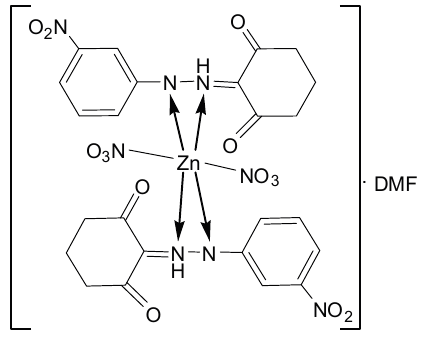
Figure 8. Structure of [Zn(L 2 ) 2 (NO 3 ) 2 ]·DMF complex.